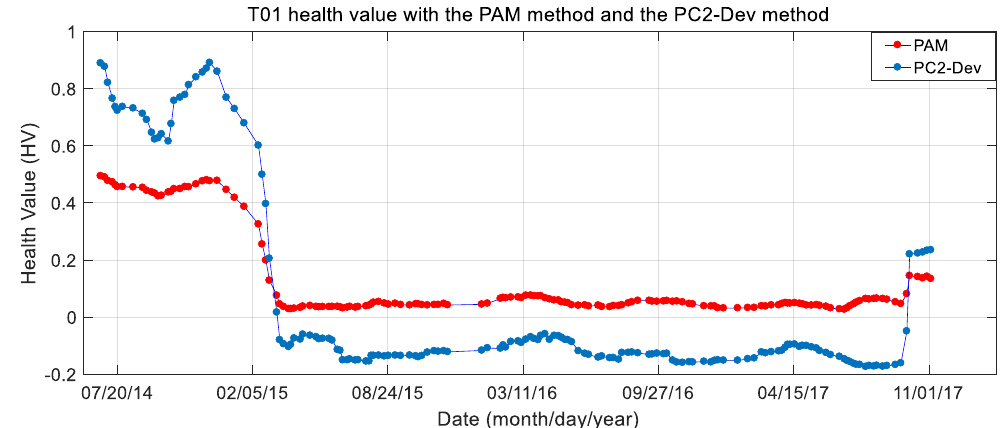
Figure 9. Health assessment result of T07 wind turbine obtained using two methods.